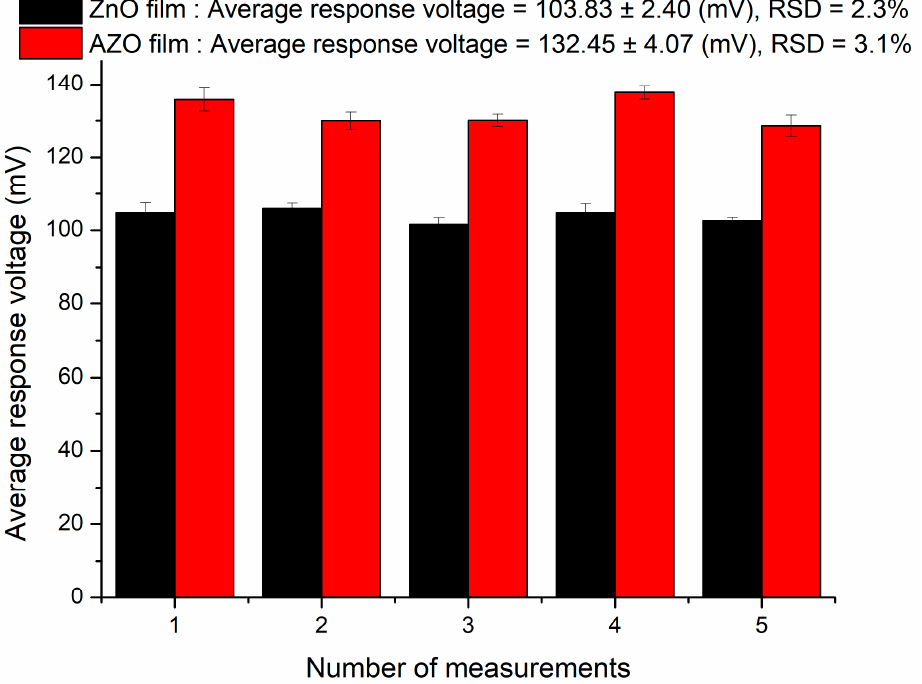
Figure 8. The repeatability of the pH sensors based on ZnO and AZO films.